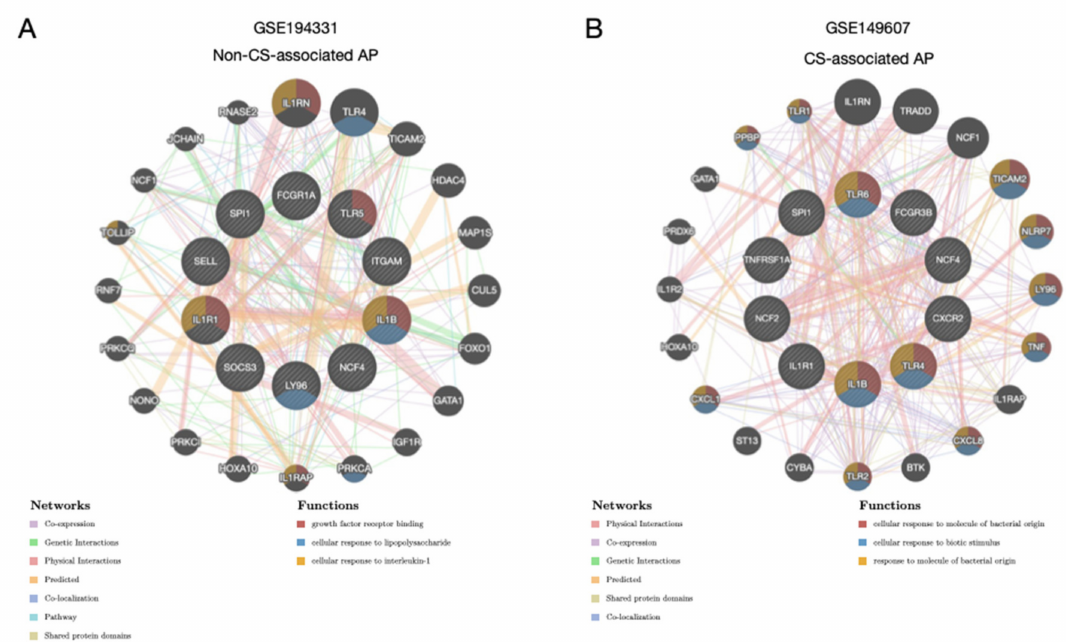
Figure 6. Protein–Protein networks of the hub genes. ( A , B ) The protein–protein interaction networks of the top 10 genes in the correlation profiles of GSE194331 and GSE149607 constructed using GeneMANIA. Interconnections between proteins are shown in terms of physical interaction, co- expression, predicted, co-localization, common pathway, genetic interaction, and shared protein domains. The top three enriched pathways are shown for the two